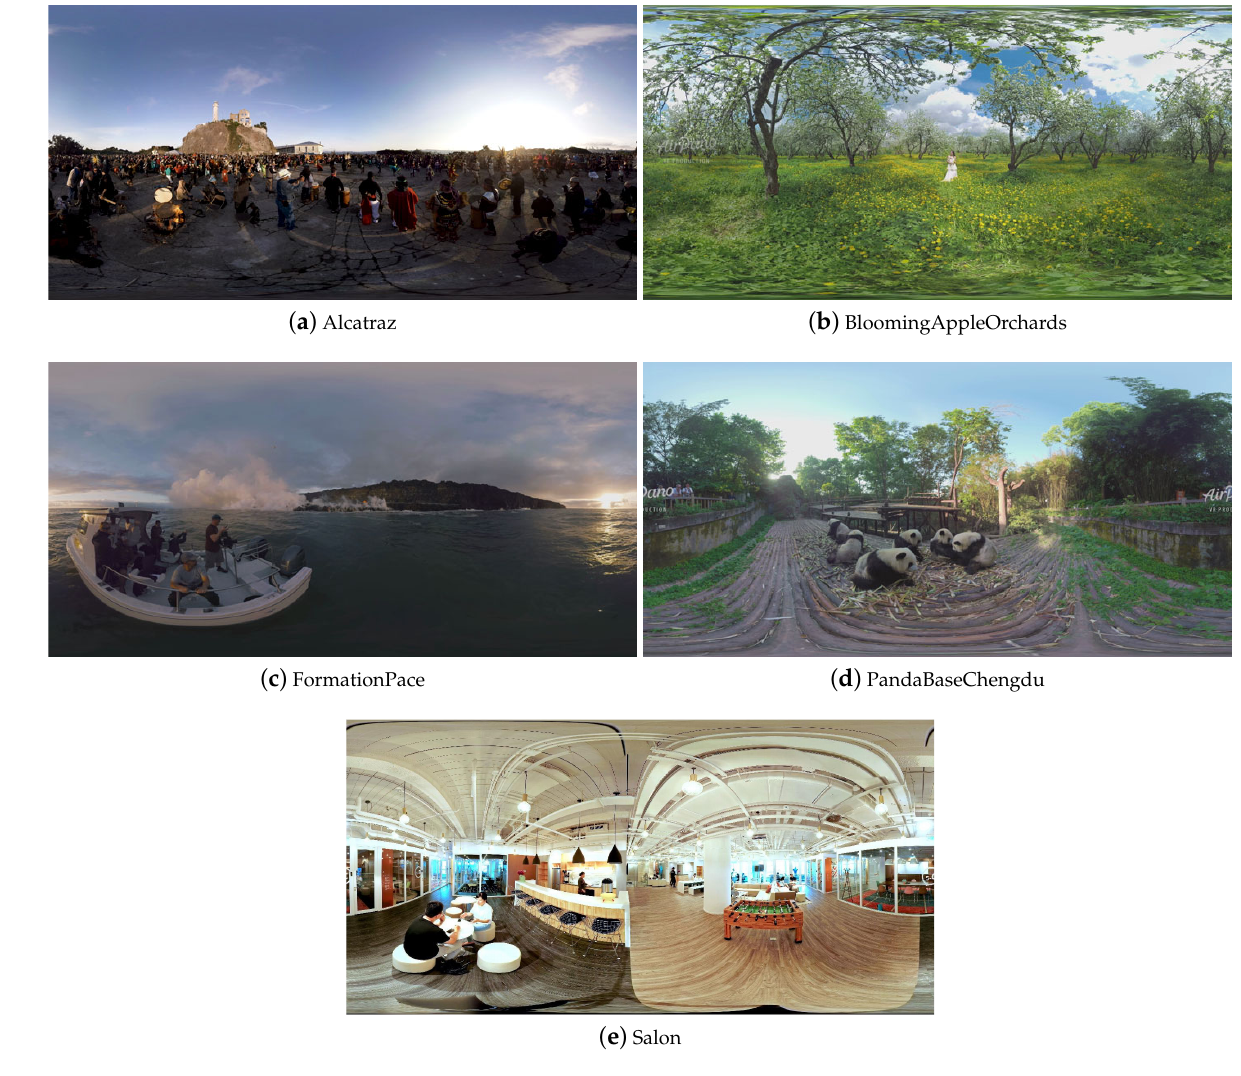
Figure 4. Sample frames of the five 360 ◦ cover videos in equirectangular projection [16,17].